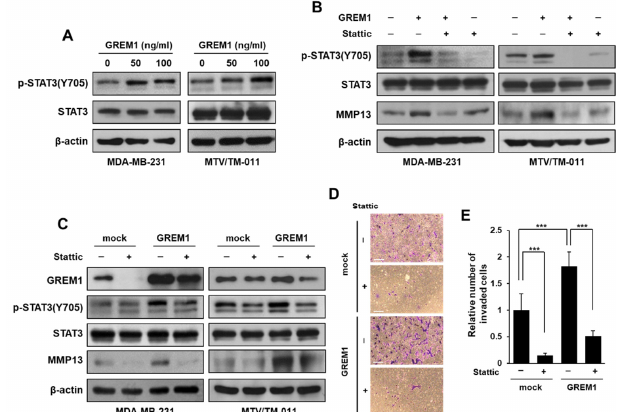
Figure 7. GREM1 increases MMP13 expression via STAT3 activation. ( A ) Cells were stimulated with different concentrations of recombinant GREM1 protein (10, 50, or 100 ng/mL) for 30 min, and the lysates were collected for immunoblot analysis. ( B ) Cells were incubated with Stattic (5 µM) for 2 h and then stimulated with recombinant GREM1 protein (MDA-MB-231, 50 ng/mL; MTV/TM-011, 100 ng/mL) for another 30 min (pSTAT3 and STAT3) or 48 h (MMP13). The lysates were immunoblotted with the indicated antibodies. ( C ) Cells were transfected with expression vector of mock or GREM1 for 48 h and then incubated with Stattic (5 µM) for another 30 min (pSTAT3 and STAT3) or 24 h (GREM1 and MMP13). The lysates were subjected to immunoblot analysis. ( D , E ) MTV/TM-011 cells were transfected with expression vector of mock or GREM1 for 24 h. The cells were seeded into matrigel-coated inserts with medium containing vehicle or Stattic (1 µM) and incubated for 30 h, followed by the invasion assay. Scale bar = 200 µm. Data are presented using triplicate wells per group and statistical significance was determined by one-way ANOVA. ***, p < 0.001.